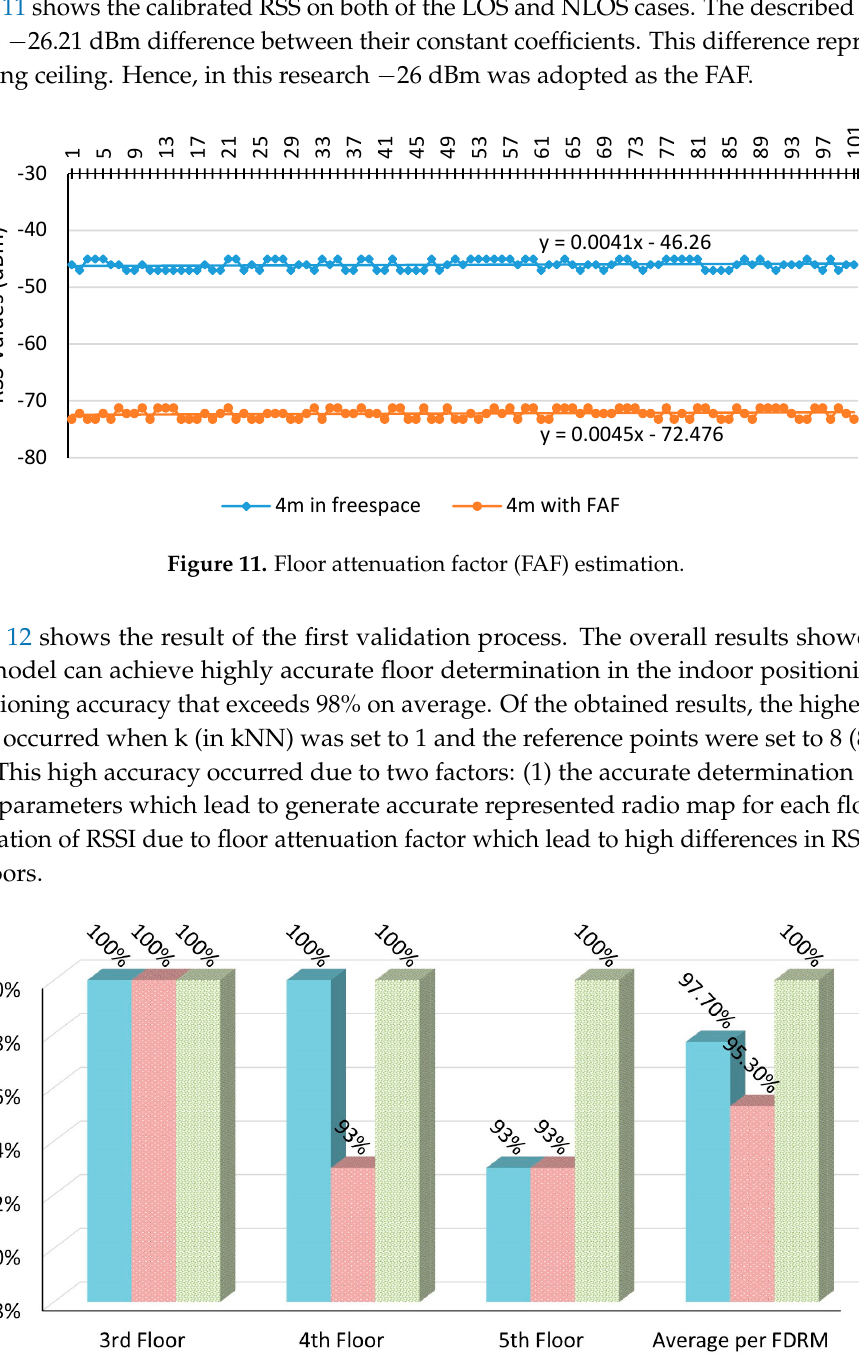
Figure 10. Wall attenuation factor (WAF) estimation.